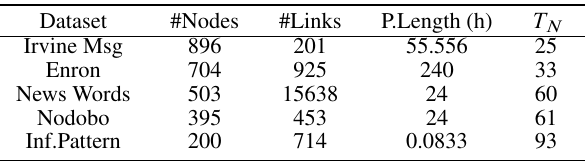
Table 1 Statistical characters of